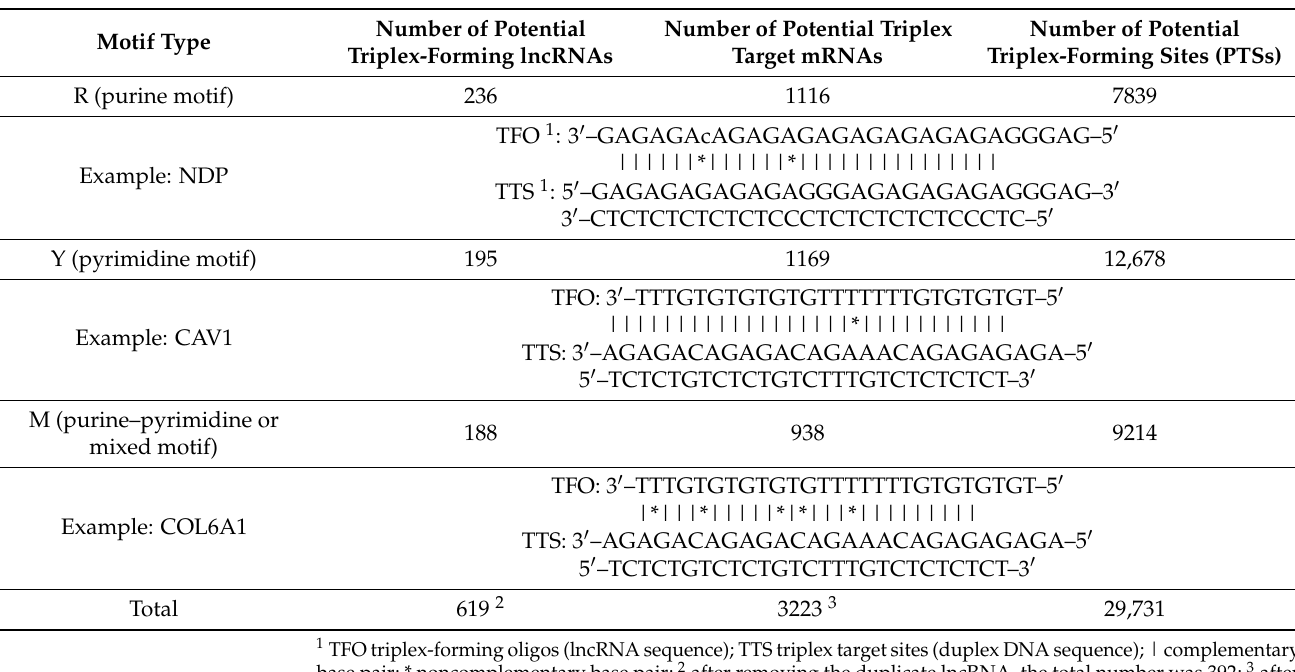
Table 2. Statistics of the triplex motif PTS sites and TFOs in our study.